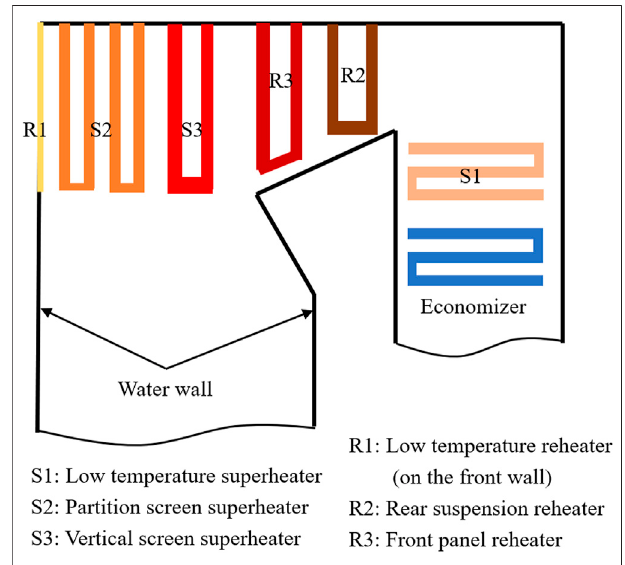
FIGURE 3 | Schematic diagram of the arrangement of heat